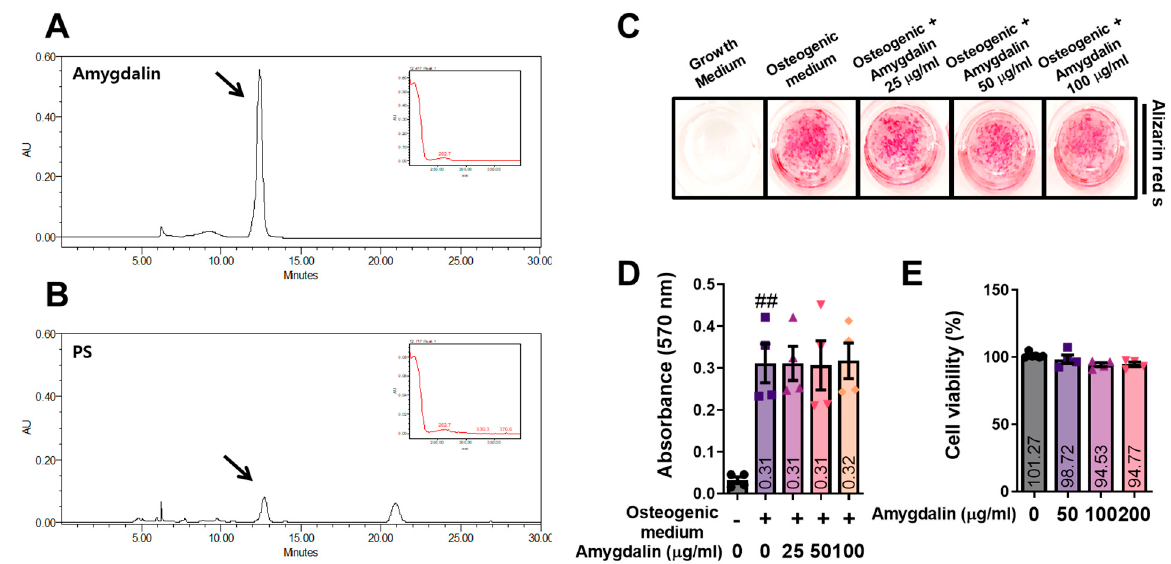
Figure 7. HPLC analysis peaks of ( A ) amygdalin and ( B ) PS, with peak detection at 210 nm. ( C ) The osteoblast differentiation-promoting effect of amygdalin verified by alizarin red S staining. ( D ) Data for absorbance of alizarin red S dye measured by ELISA. ( E ) The cytotoxicity of amygdalin was determined by the CCK-8 assay. The shapes (triangles, squares, etc.) shown in each graph are values for each round of the experiment. ## p < 0.01 versus the non-treated cells